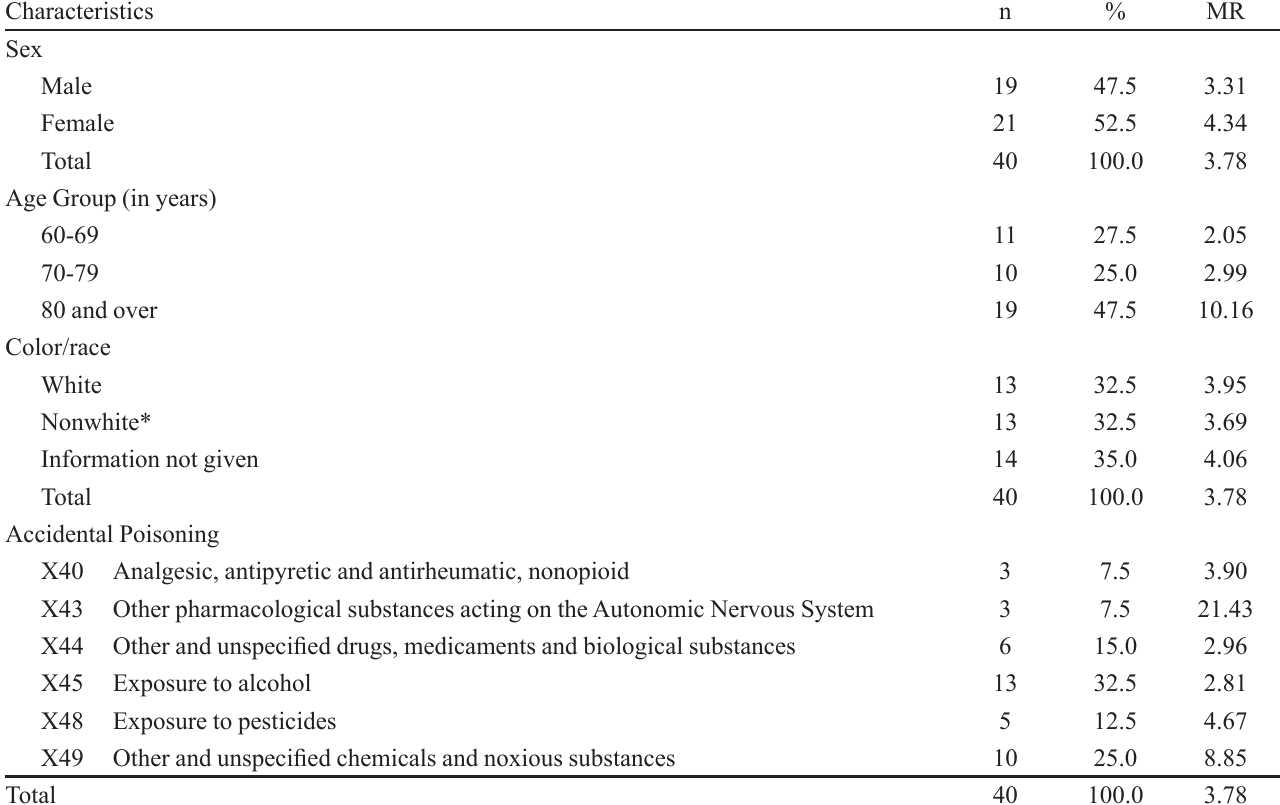
TABLE V – Demographic and epidemiological characteristics of elderly inpatients by number of deaths and mortality rates.